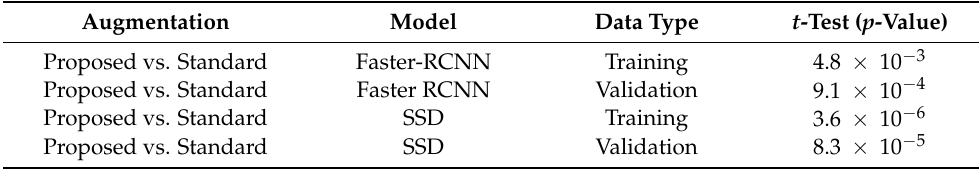
Table 5. Pairwise comparison between the minimum training and validation losses from the proposed augmentation pipeline and the standard augmentation method. Augmentation Model Data Type t -Test ( p -Value) Proposed vs. Standard Faster-RCNN Training 4.8 × 10 − 3 Proposed vs. Standard Faster RCNN Validation 9.1 × 10 − 4 Proposed vs. Standard SSD Training 3.6 × 10 − 6 Proposed vs. Standard SSD Validation 8.3 × 10 −